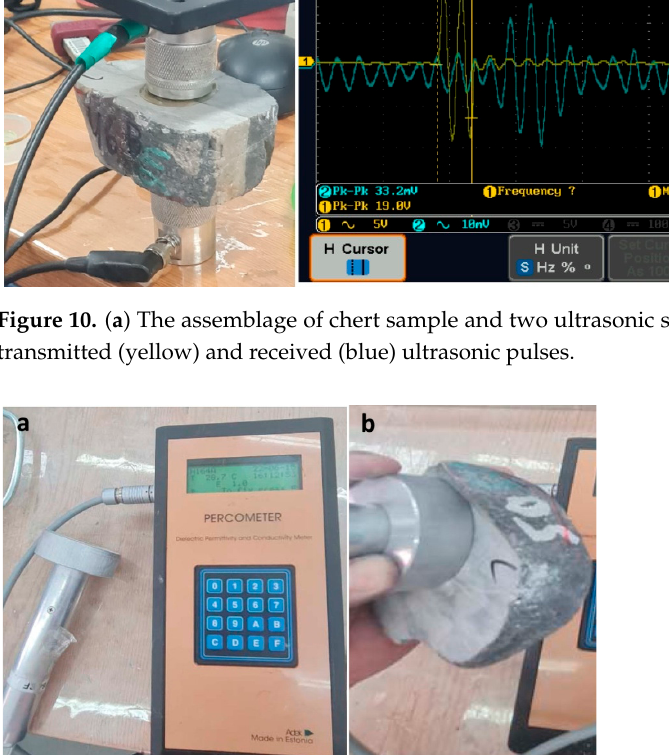
Figure 9. ( a ) The ∼ 1.5 cm deep borehole in chert rock sample after one-hour drilling; ( b ) the typical assemblage of the chert rock samples prepared for modified Brazilian test; ( c ) the typical shape of the chert sample split between two steel pins; ( d ) the typical strain-stress diagram.